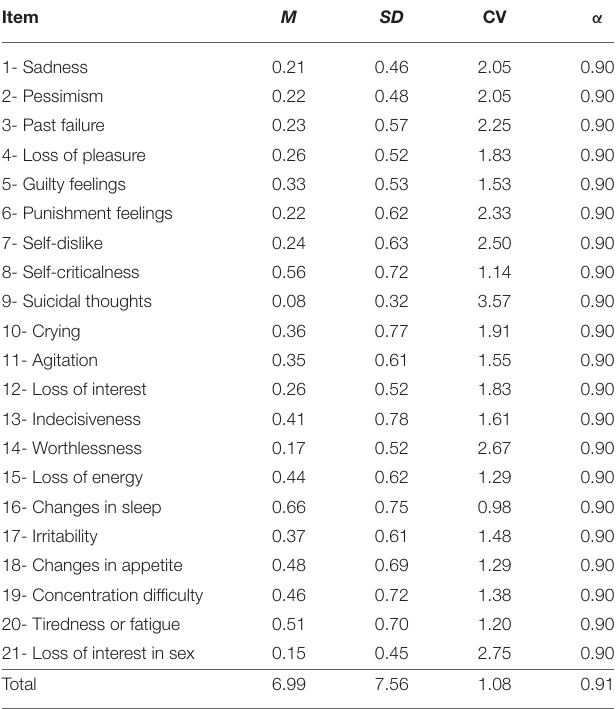
TABLE 1 | Psychometric characteristics of the Beck Depression Inventory-II for college students ( N = 12,677).